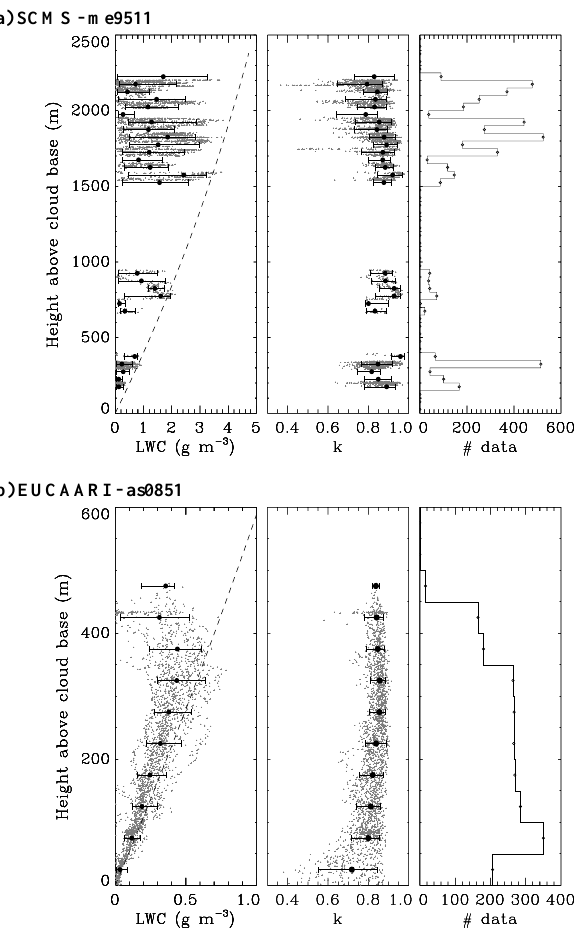
Fig. 5. Vertical profiles of LWC, the k factor and the number of data points in each 50m altitude interval above cloud base. For LWC and the k factor, the mean value (black dot) and the 1st and 9th deciles of the frequency distribution (error bar) are superimposed to the data (grey points). The dashed line on the left panel corresponds to the adiabatic LWC